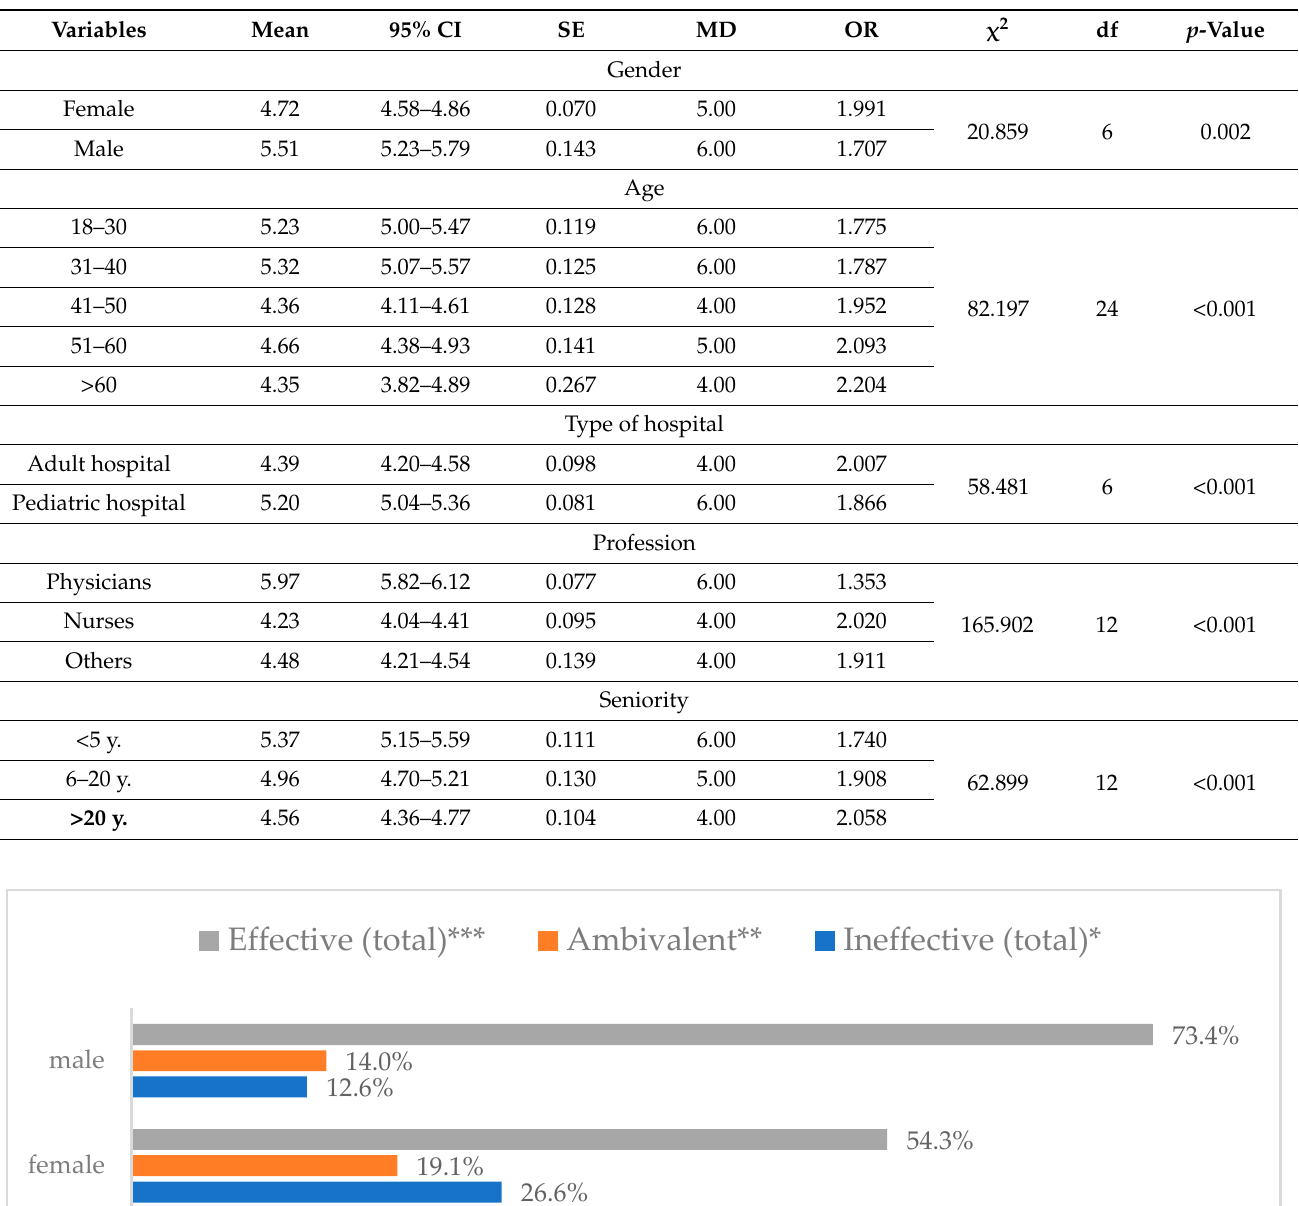
Table 5. Evaluation of influenza vaccination as a means of preventing influenza virus infection by sociodemographic category ( N = 950).